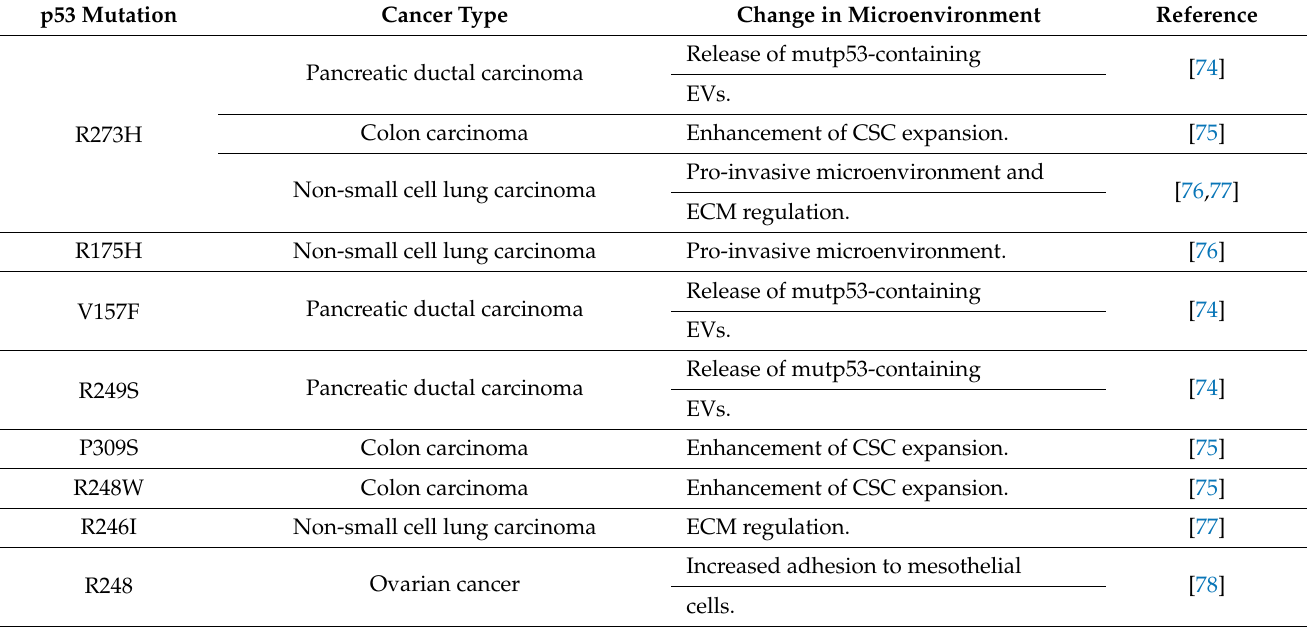
Table 1. Relationship between p53 mutations and tumor